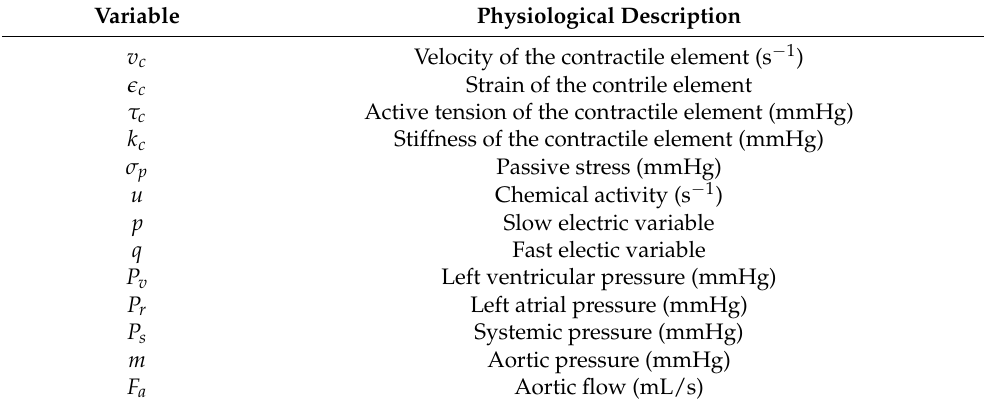
Table 1. Variables and their physiological meaning.